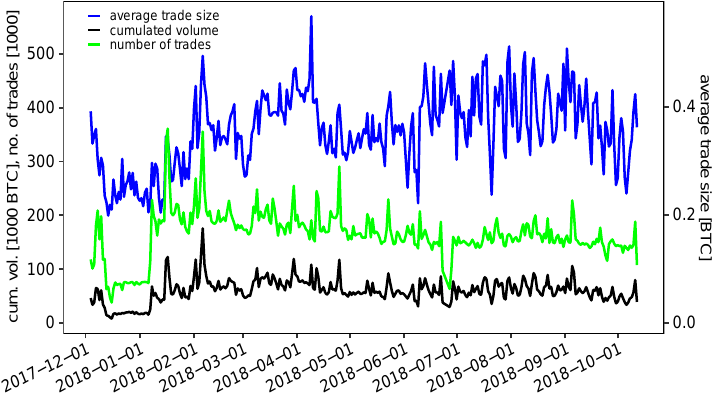
Figure 11. Daily trading volume, number of trades and daily average trade size. We aggregate the daily volume and the daily number of trades in universal coordinated